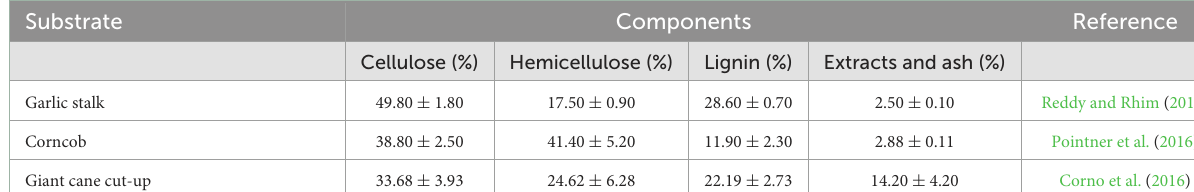
TABLE 1 Composition of garlic stalk, corncob, and giant cane cut-up as reported in previous works. Substrate